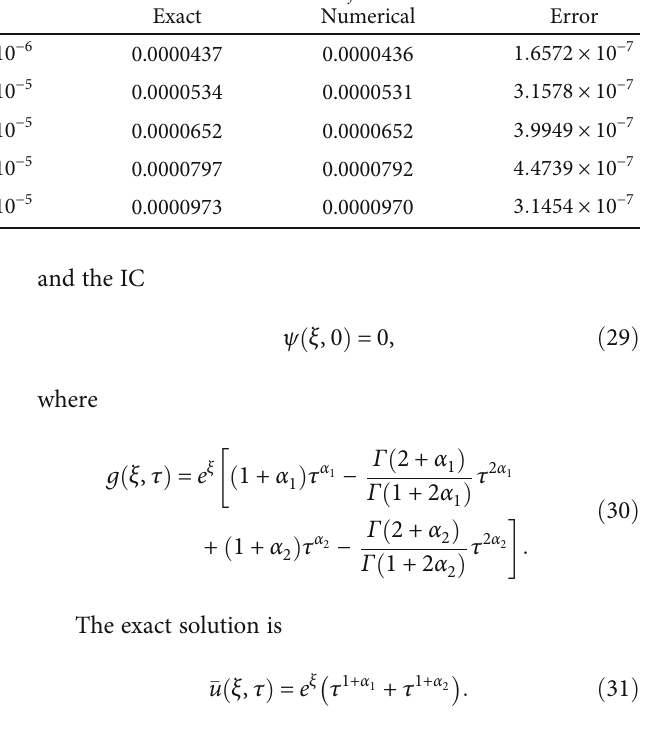
Table 8: The numerical display of solutions of Example 2 at di ff erent time level with N = 70 , α